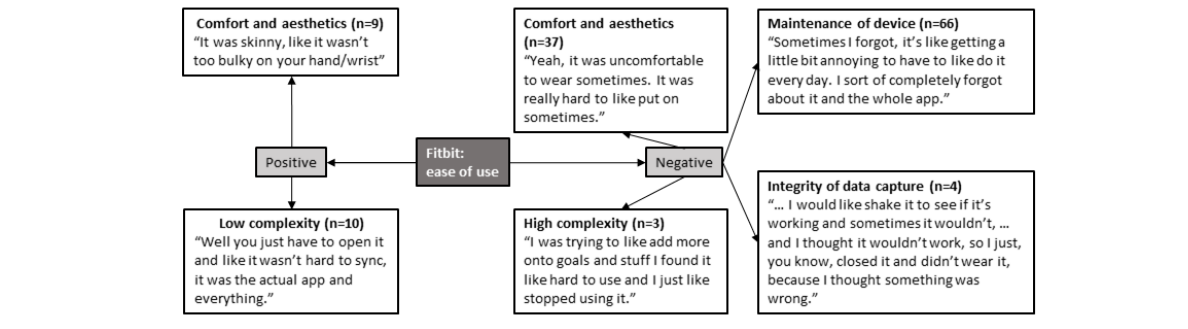
Fitbit: Perceived